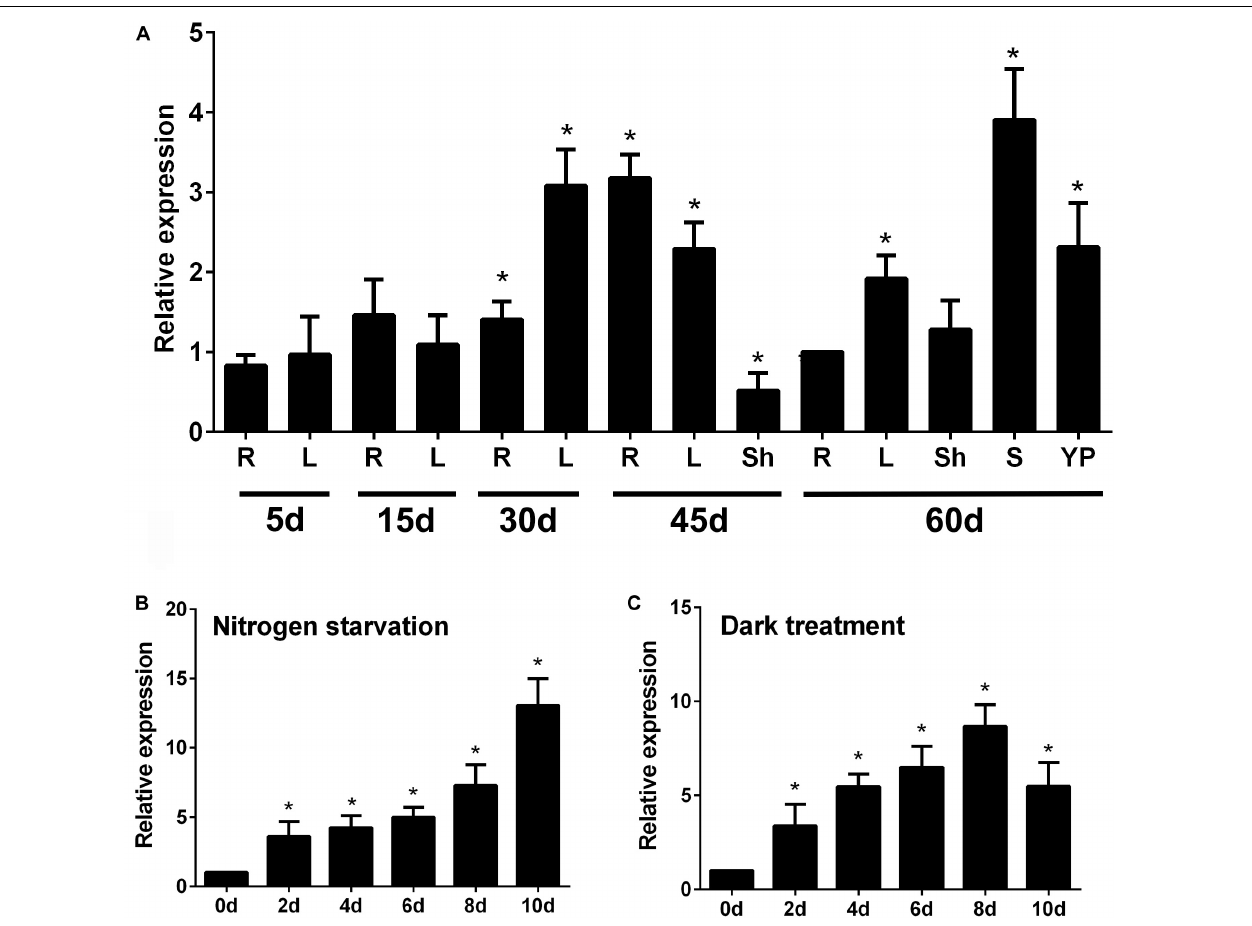
FIGURE 2 | Expression patterns of OsATG8b in developing tissues of rice by qRT-PCR analysis. (A) Expression of OsATG8b in developing tissues. Total RNA was isolated from roots €, sheaths (Sh), young panicles (YP), stems (S), and leaves (L) at different growth stages. OseEF-1a was used as an internal reference. (B,C) Expression profiles of OsATG8b in an N-starvation solution (B) and in darkness (C) . Total RNA was isolated from 5-leaf seedlings treated for 2, 4, 6, 8, and 10-day with N-starvation and darkness. Error bars indicate standard deviations of independent biological replicates ( n = 3). One asterisk (* p < 0.05, t -test) represents significant